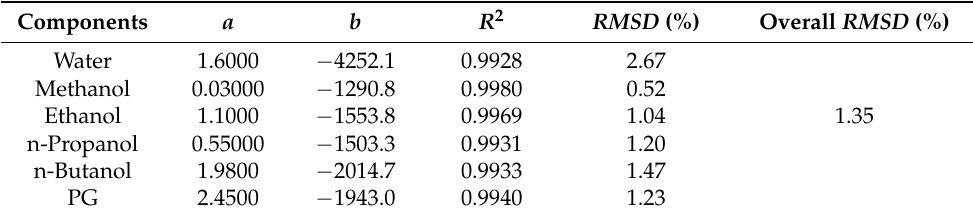
Table 6. The results of the van’t Hoff model for TRV in six different mono-solvents.